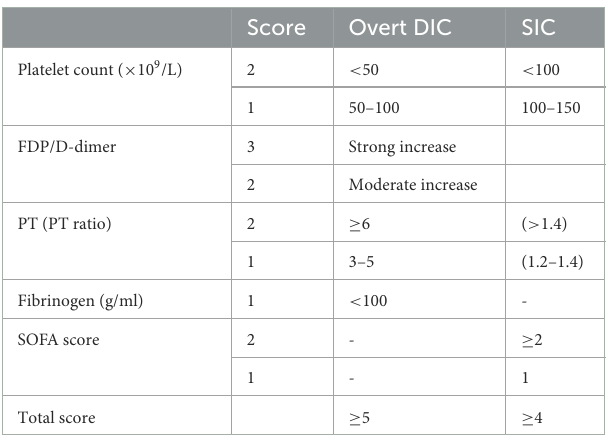
TABLE 1 ISTH overt DIC and SIC scoring